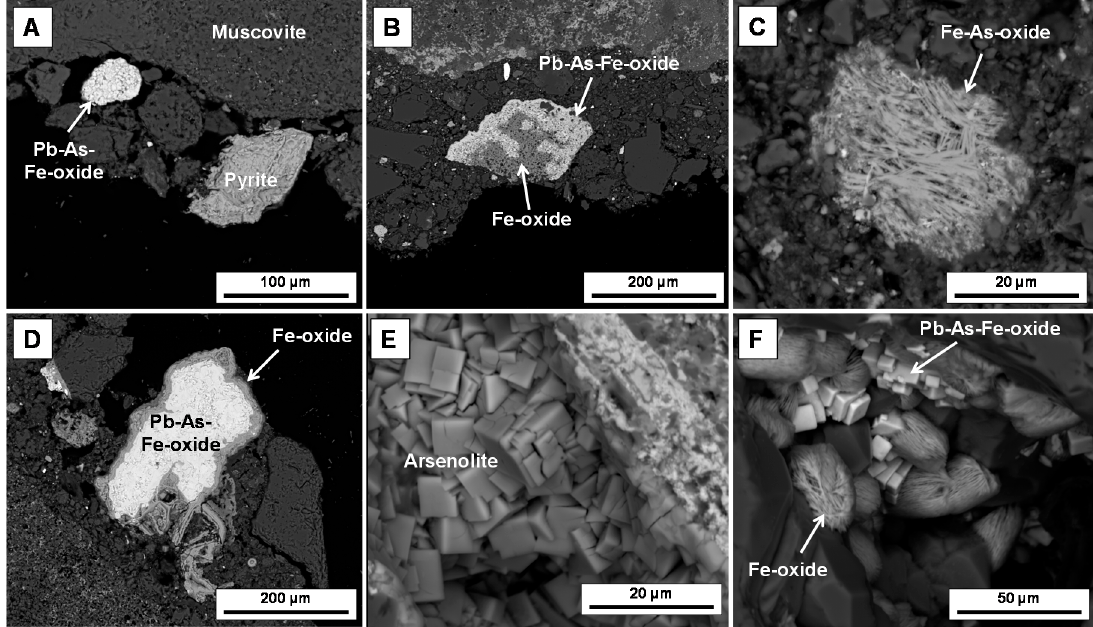
Figure 3. ( A ) Weathered pyrite grain associated with muscovite, with internal striations displayed but no visible reaction products, with a secondary Pb-As-Fe oxide phase also observed; ( B ) Pb-As-Fe oxide phase associated with Fe-oxide, both displaying porous texture; ( C ) Pb-As-Fe oxide phase rimmed by Fe-oxide; ( D ) Fibrous habit Fe-As oxide with diffuse grain boundary; ( E ) Cubic arsenolite; ( F ) Cubic Pb-Fe-As oxides intergrown with fibrous Fe-oxides.